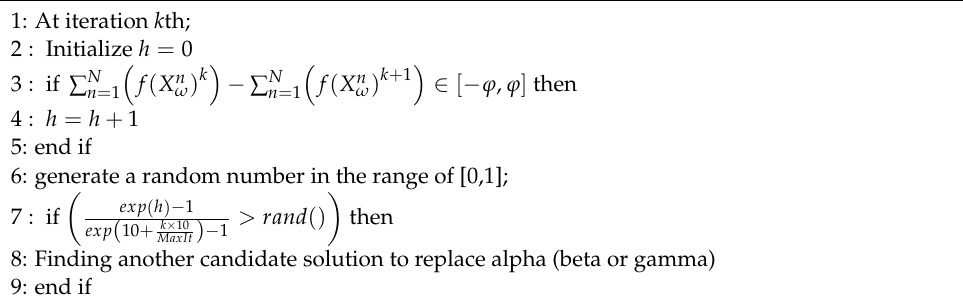
Algorithm 1 . Robust tolerance ‐ based adjust searching direction mechanism